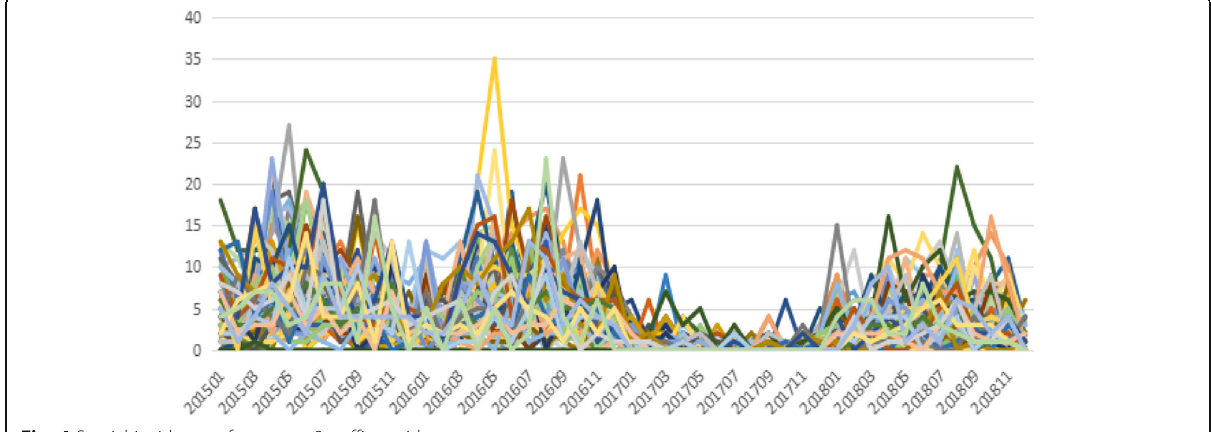
Fig. 4 Spatial incidence of category 2 traffic accidents